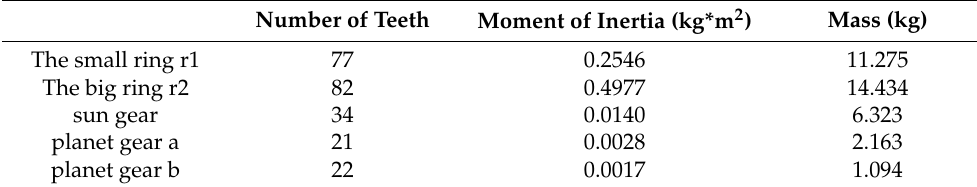
Table 1. Main parameters of the transmission system. Number of Teeth Moment of Inertia (kg*m 2 ) Mass (kg) The small ring